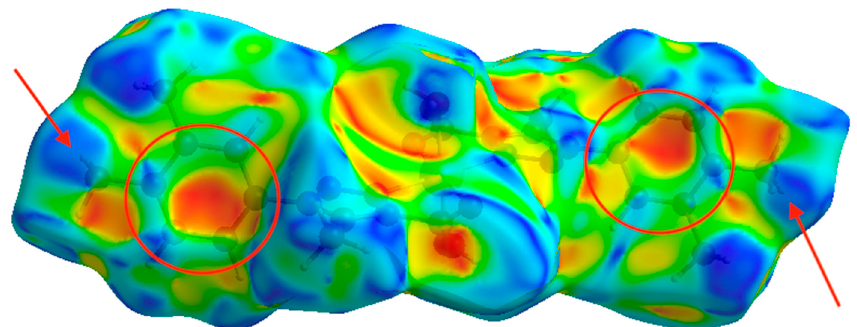
Figure 5. Shape index surface for ZnL 2 (H 2 O) 2 complex. Red–orange and green–blue colors indicate zones engaging in weak interactions and their reciprocal contacts, respectively. Isovalues range from − 1.0 (red–orange) to +1.0 (green–blue). Table 2. Contributions of the principal intermolecular contacts (%) in compounds 1 and 2 Contact 1 2 H···H